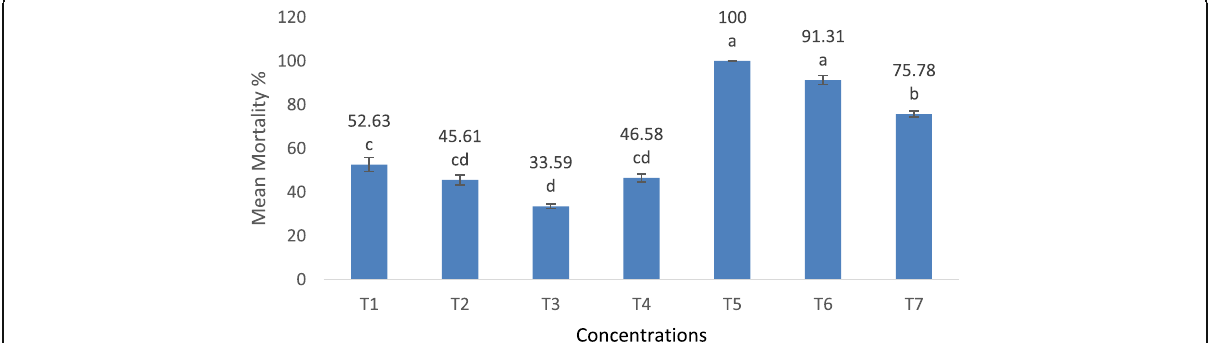
Fig. 1 Percentage mean mortality of 2nd instar larvae of Spodoptera litura after every 24 h against various concentrations sprayed on cotton plants in